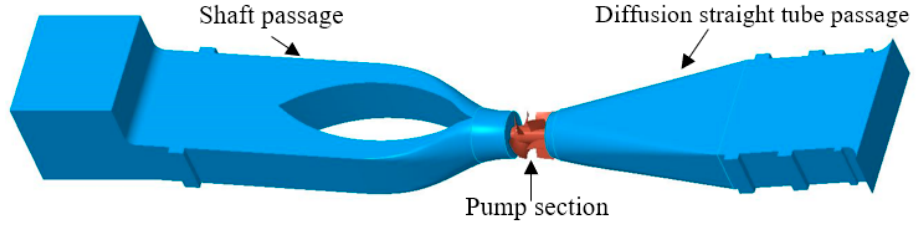
Figure 2. Bidirectional shaft tubular pump system.